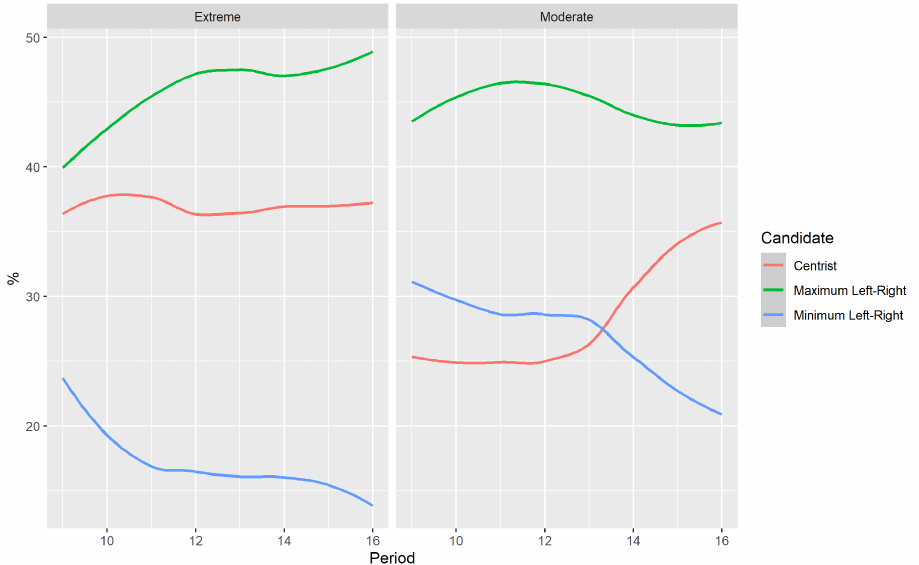
Figure 3. Candidates’ vote shares.